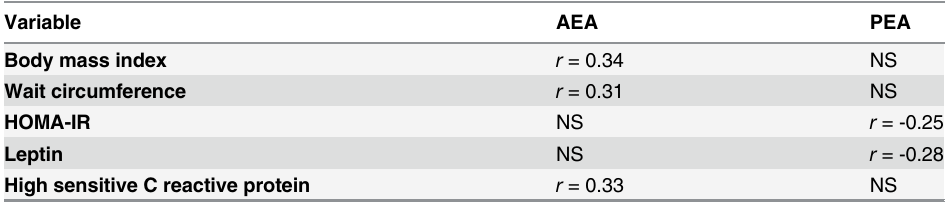
High sensitive C reactive protein Values are age- and sex-adjusted partial correlations with Bonferroni adjustment for multiple testing for a signi fi cance level <